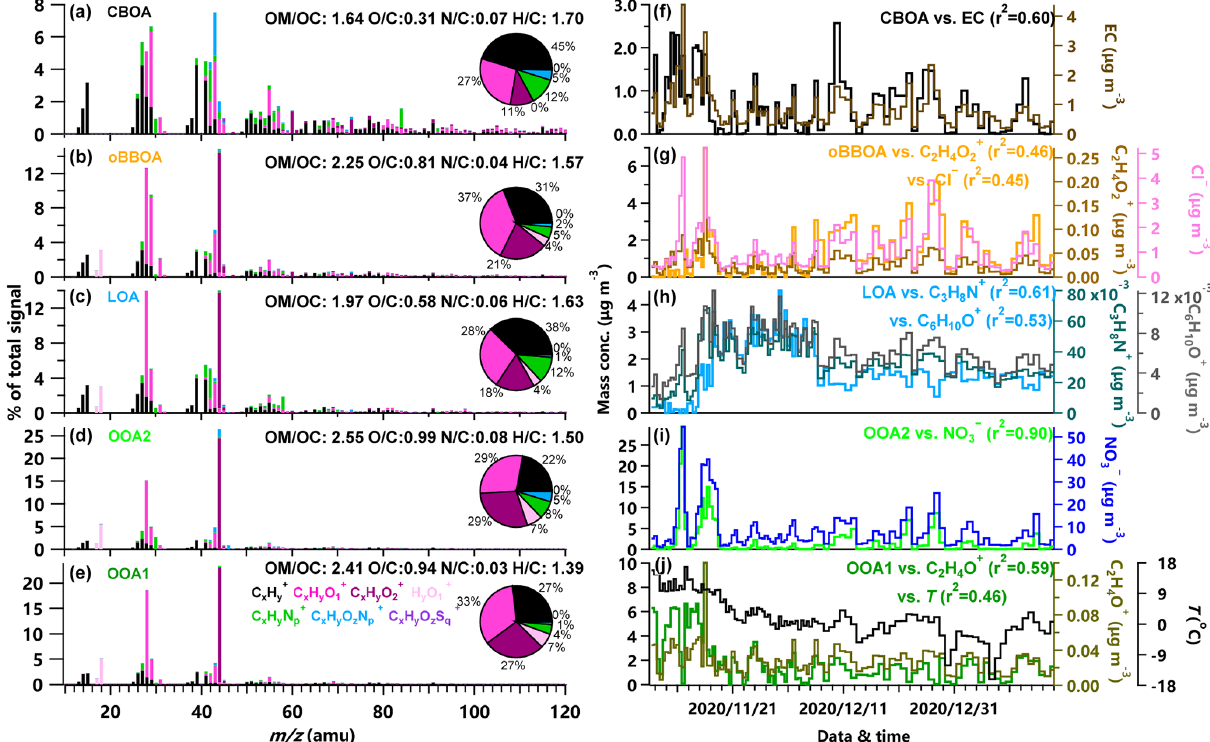
Figure 3. (a–e) High-resolution mass spectra of WSOA factors (CBOA, oBBOA, LOA, OOA2, and OOA1) resolved by PMF, (f–j) time series of PMF-resolved WSOA factors, corresponding external tracers, and the correlation coefficients between them. Also shown in pan- els (a–e) are the elemental ratios of WSOA factors that were calculated with the improved-ambient (I-A) method (Canagaratna et al., 2015) and pie charts of the average ion compositions in each